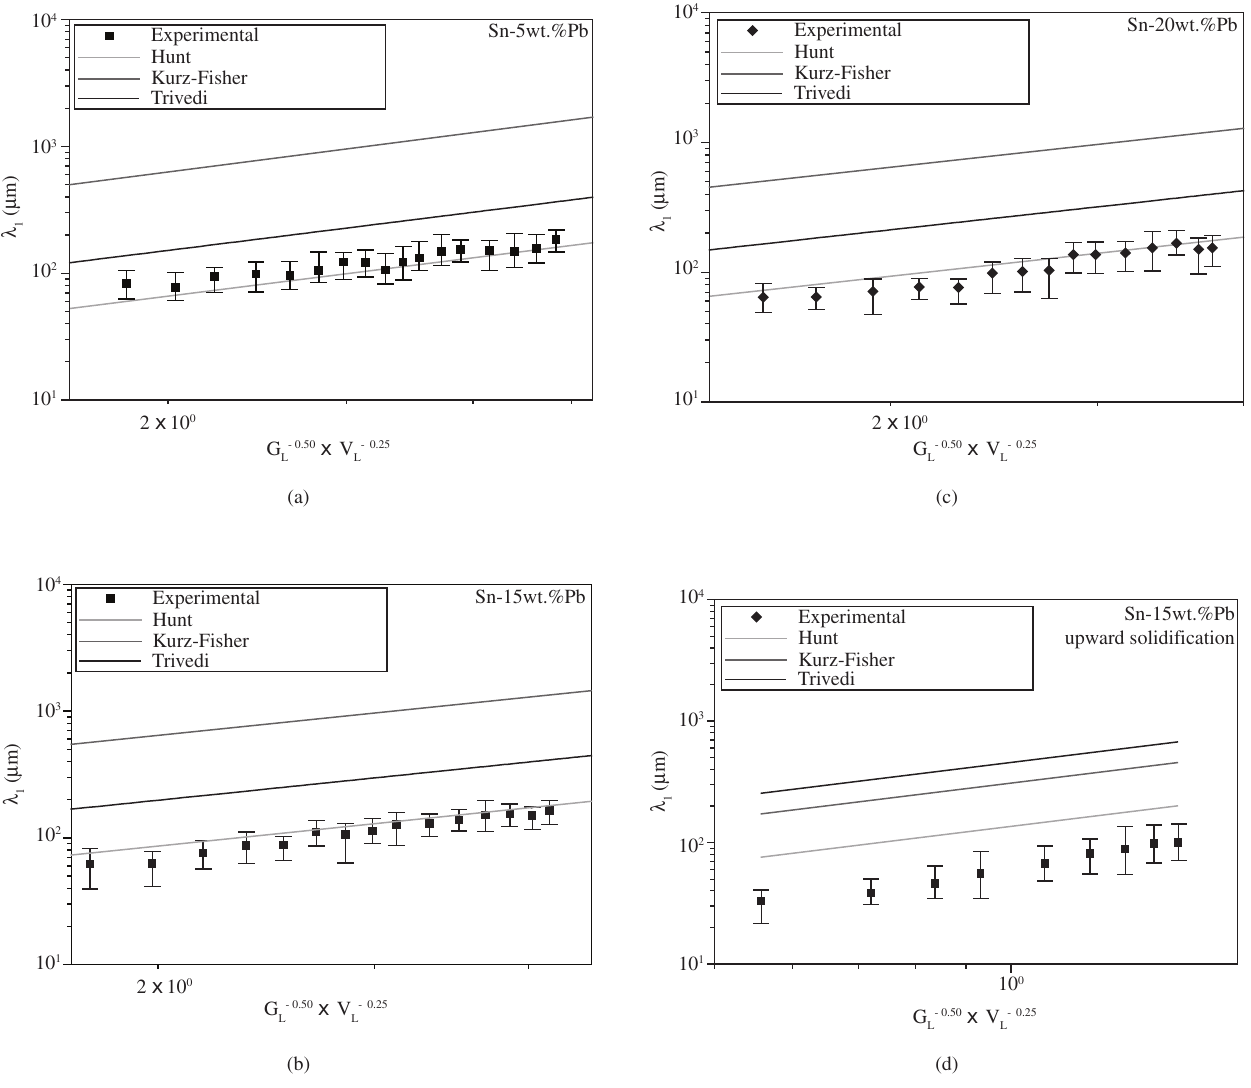
Figure 5. Comparison of experimental and theoretical (steady-state) primary dendrite arm spacings for Sn-Pb alloys solidified downwards (a, b and c) and upwards (d).